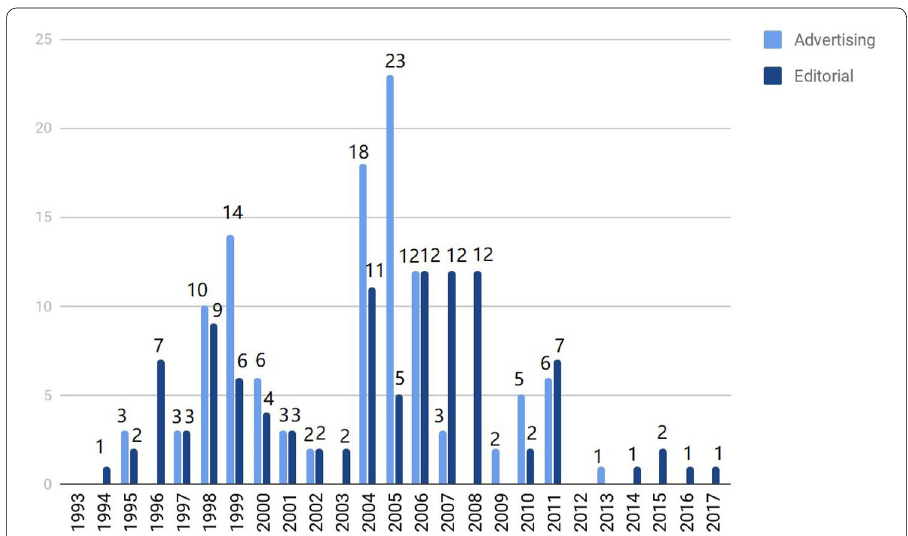
Fig. 1 Occurrences of mobile phones in advertising and editorial images in Vogue (US) and L’Officiel (FR) between 1993 and